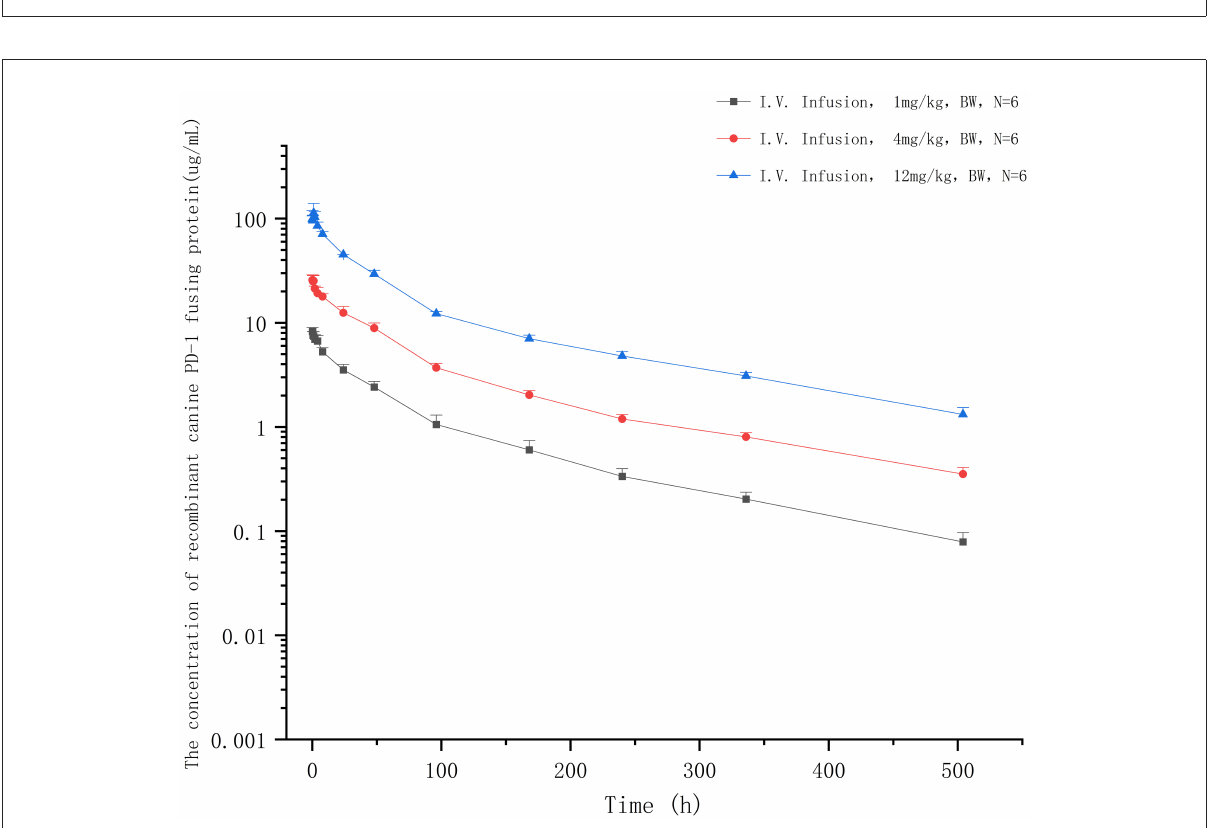
FIGURE5 The concentration–time profiles of recombinant canine PD-1 fusion protein after a single intravenous administration of 1, 4, and 12 mg/kg in canine